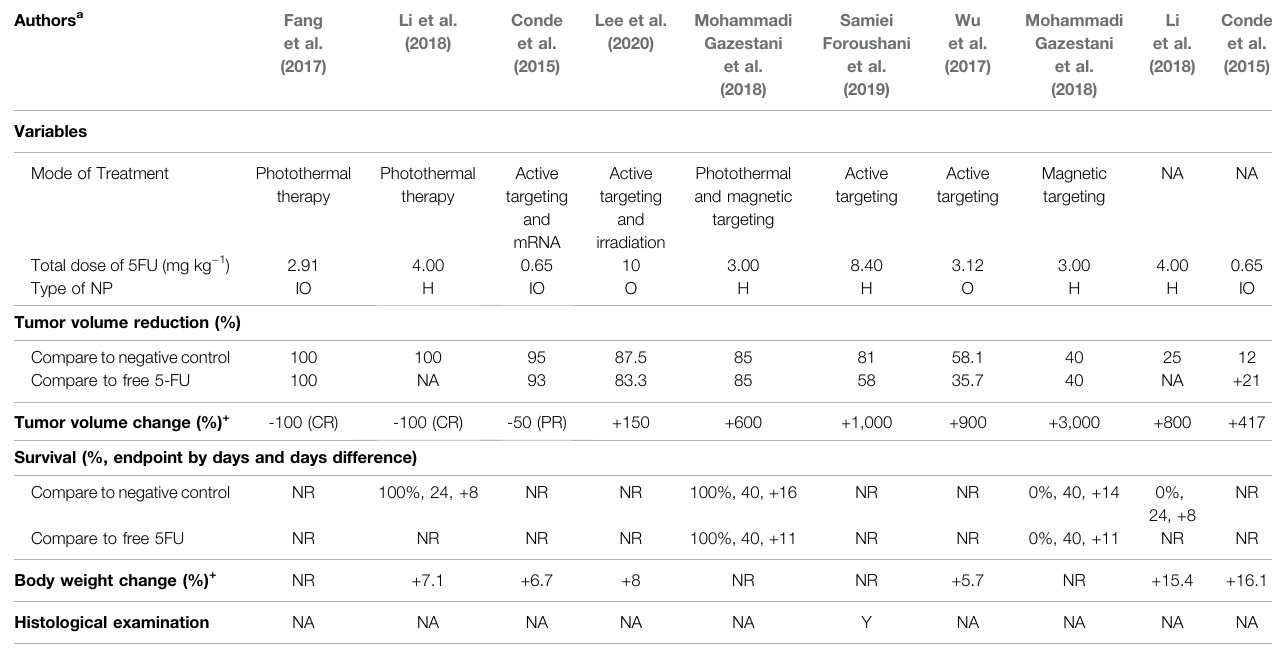
TABLE 2 | Ef fi cacy and toxicity of nanoparticles encapsulated/conjugated with 5FU. Authors